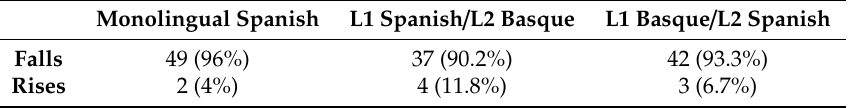
Table 2. Numbers and percentages of information-seeking yes / no interrogatives with rising–falling and rising final contours (Falls and Rises, respectively) for each linguistic profile in the two towns combined: Lekeitio and Ibarra.